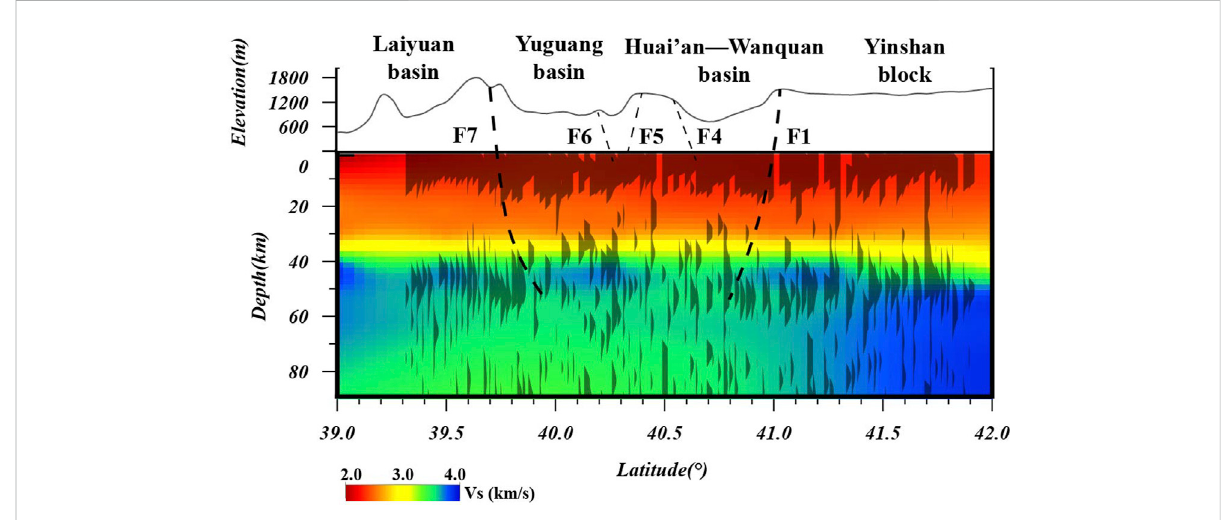
FIGURE 5 Tomography pro fi le and receiver functions. The tomography results are combined with the results reported by Tao et al. (2018).